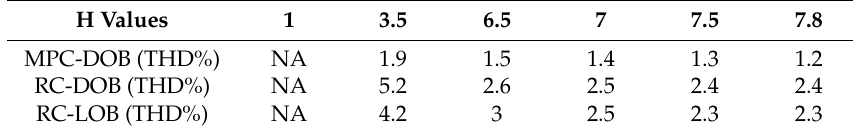
Table 3. THD values for di ff erent η under the resistive load ( R = 10 Ω ).